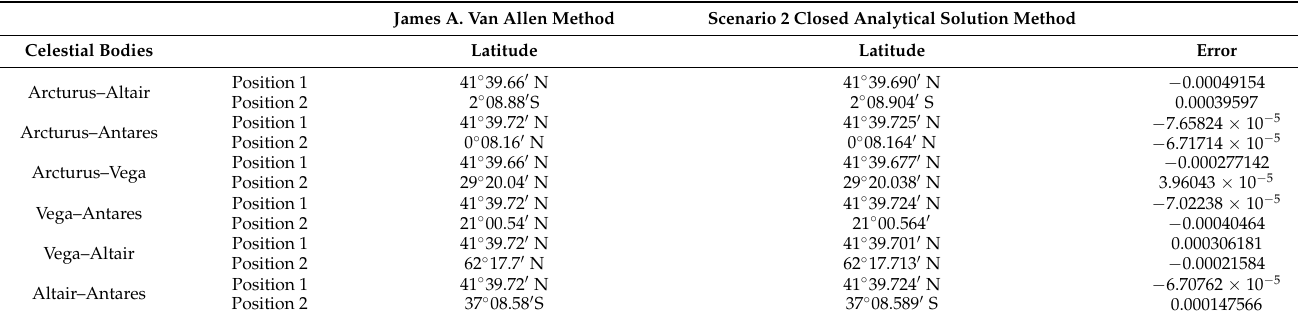
Table 8. Latitude errors of the two positioning methods.